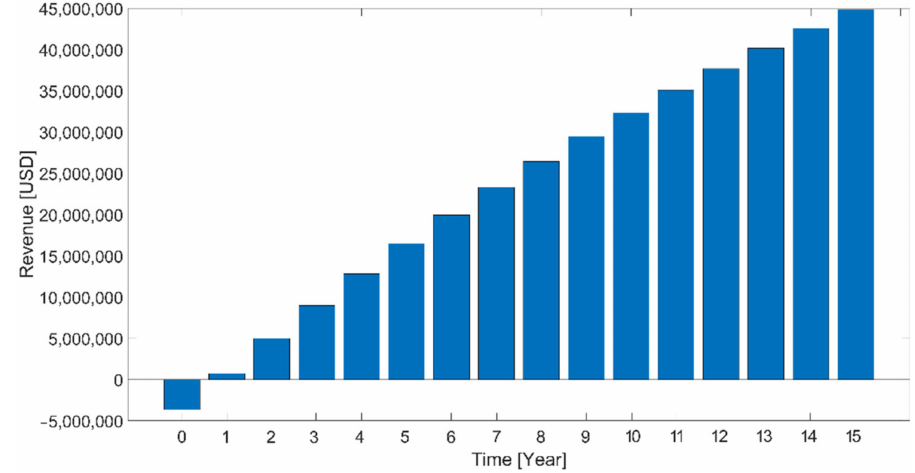
Figure 5. Free Cash Flow for Base Case A.